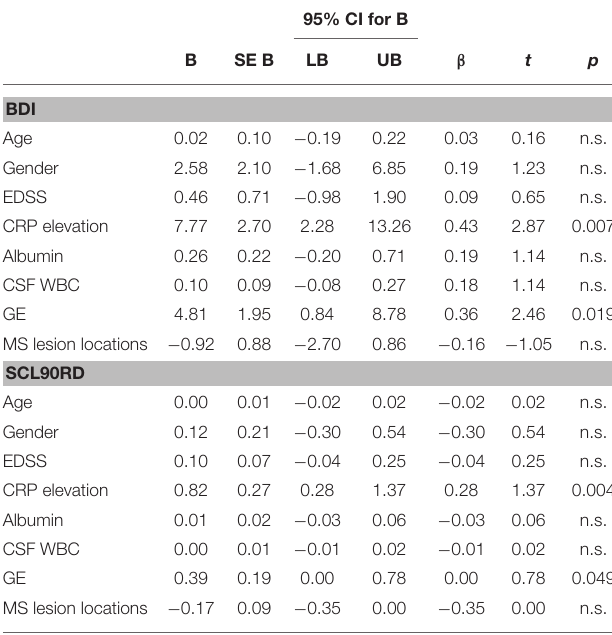
TABLE 2 | Past medical history and medications reported in the sample. TABLE 3 | Details from the two multiple linear regressions.